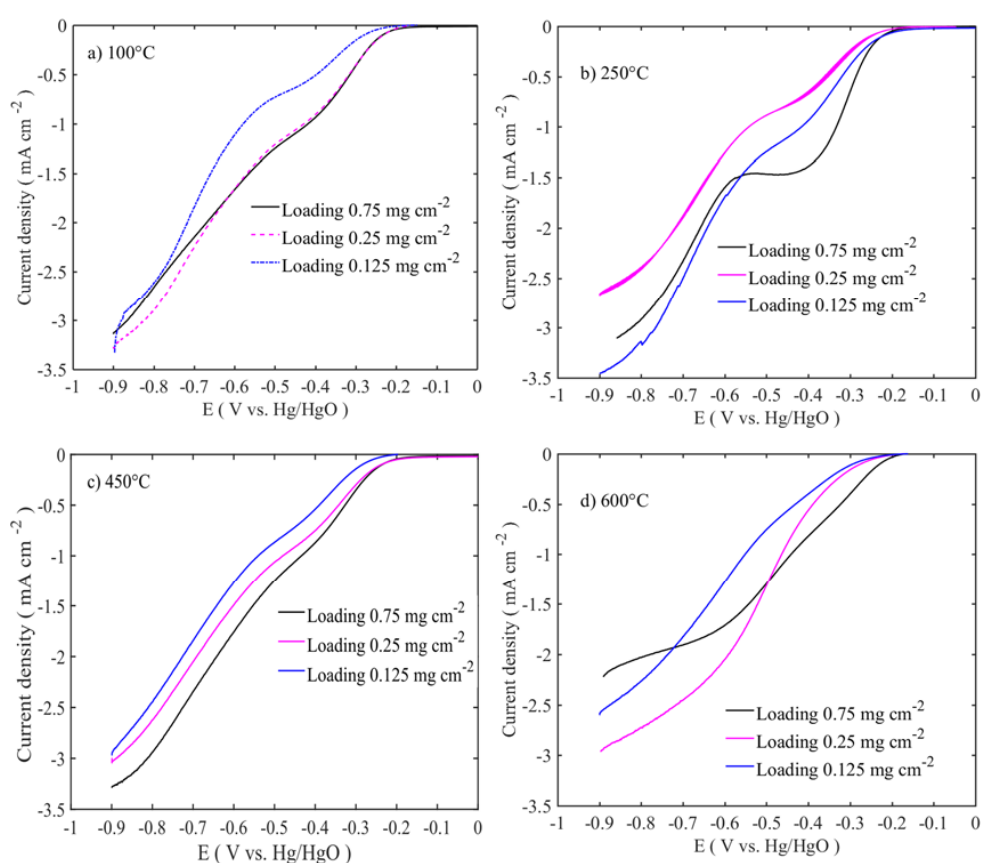
Figure 6. ORR activity of Ni Fe oxides with a sweep rate of 5 mV s − 1 at 1600 rpm at three different